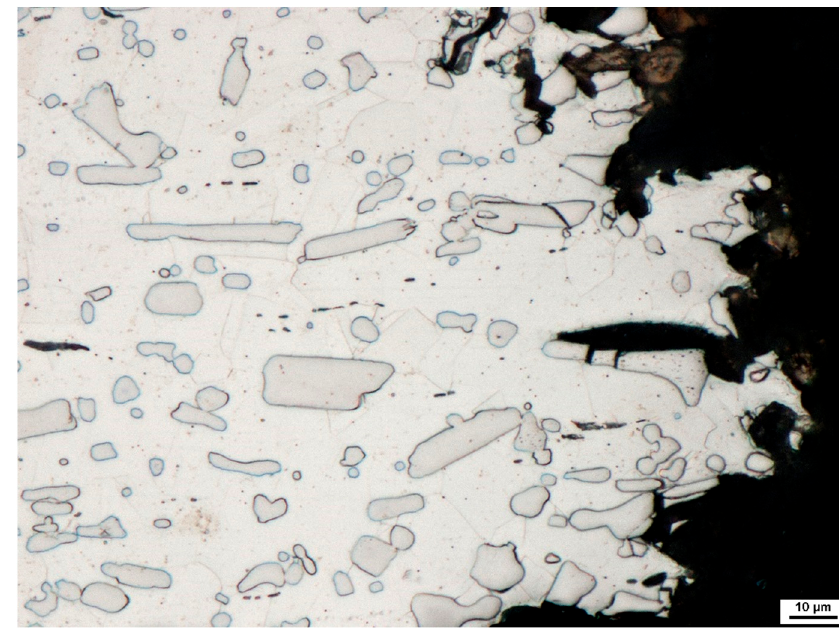
Figure 13. Fracture. Optical microscopy 500×. Etched in HNO 3 .